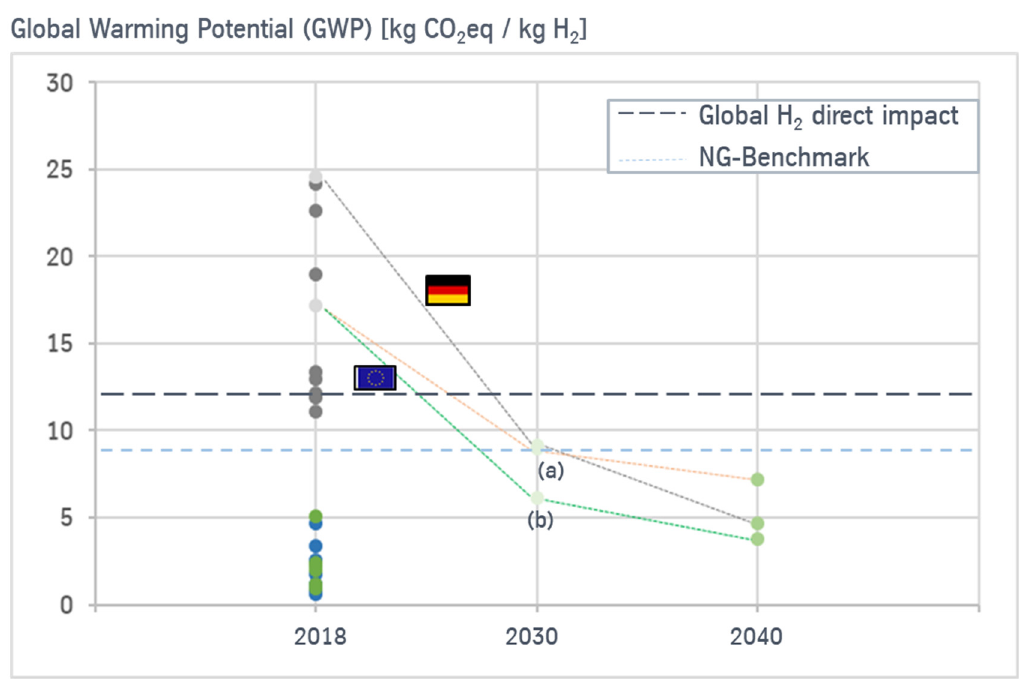
Figure 4. Development of the carbon footprint of hydrogen. For the European development, a stated policy scenario (a) and a sustainable development scenario (b) are considered, based on the IEA [34]. The German development scenario is based on Prognos et al. [35]. For the year 2018, the GWP values from the literature cited in Table 1 are listed referring to the defined colour code.